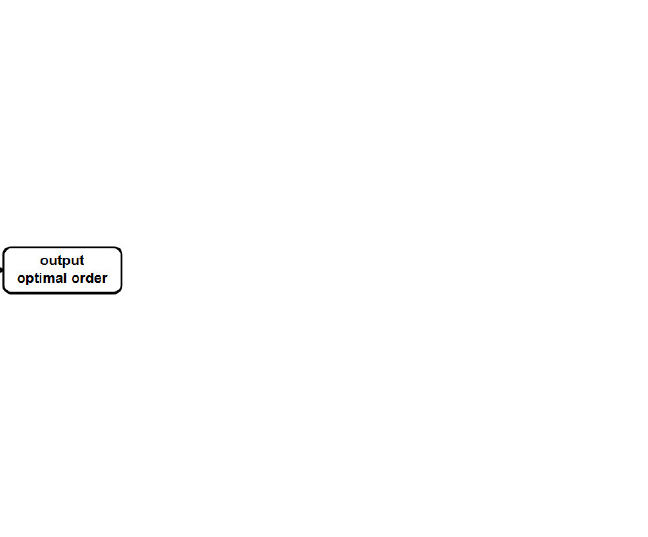
Table 2. Comparison of first-order differences versus second-order differential